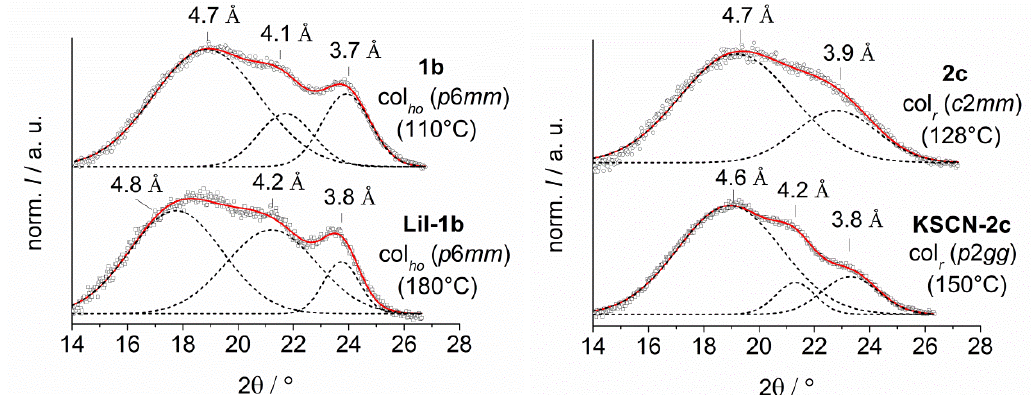
Figure 6. New phase sequence of KSCN-2b . The phase sequence of KSCN-2c is assumed to be very 226 similar. 227